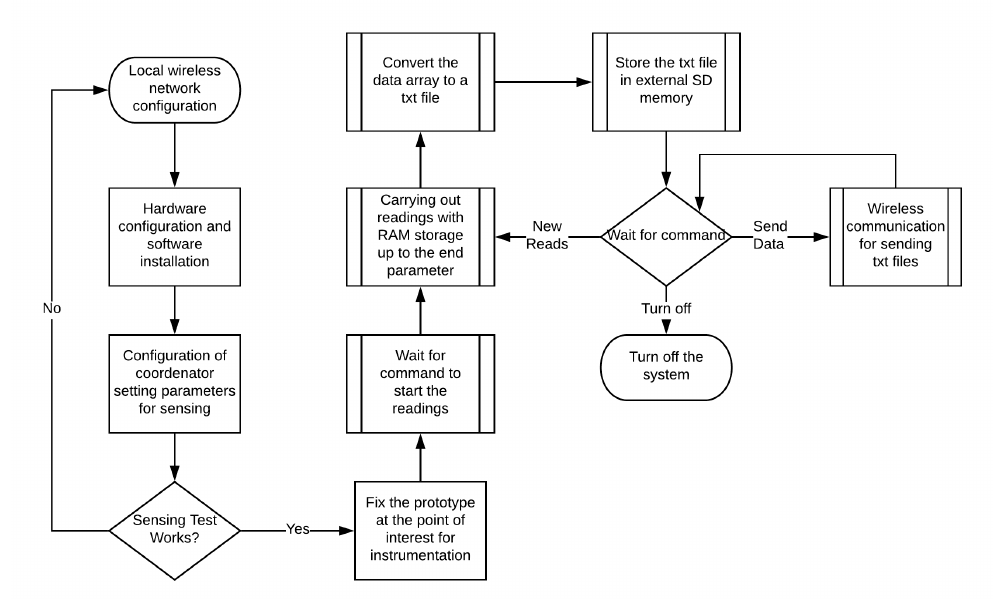
Figure 5. Flowchart of the prototype’s